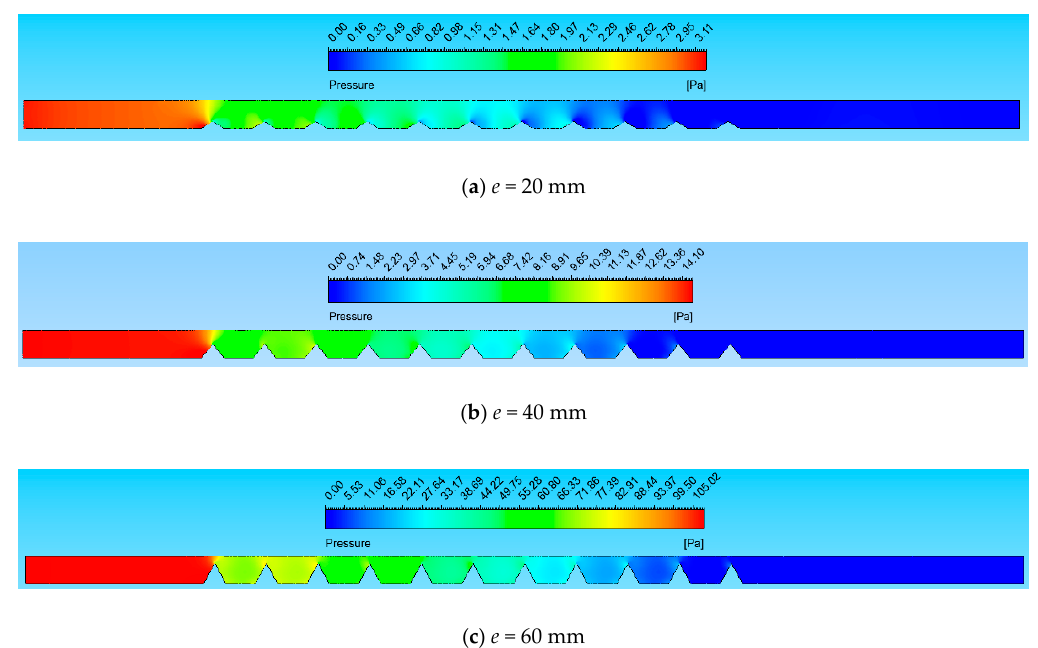
Figure 11. Contours of pressure at Reynolds number of 12,000 for a fixed value of pitch ( P = 150 mm) and length ( l = 65 mm), and different value of height ( e ).